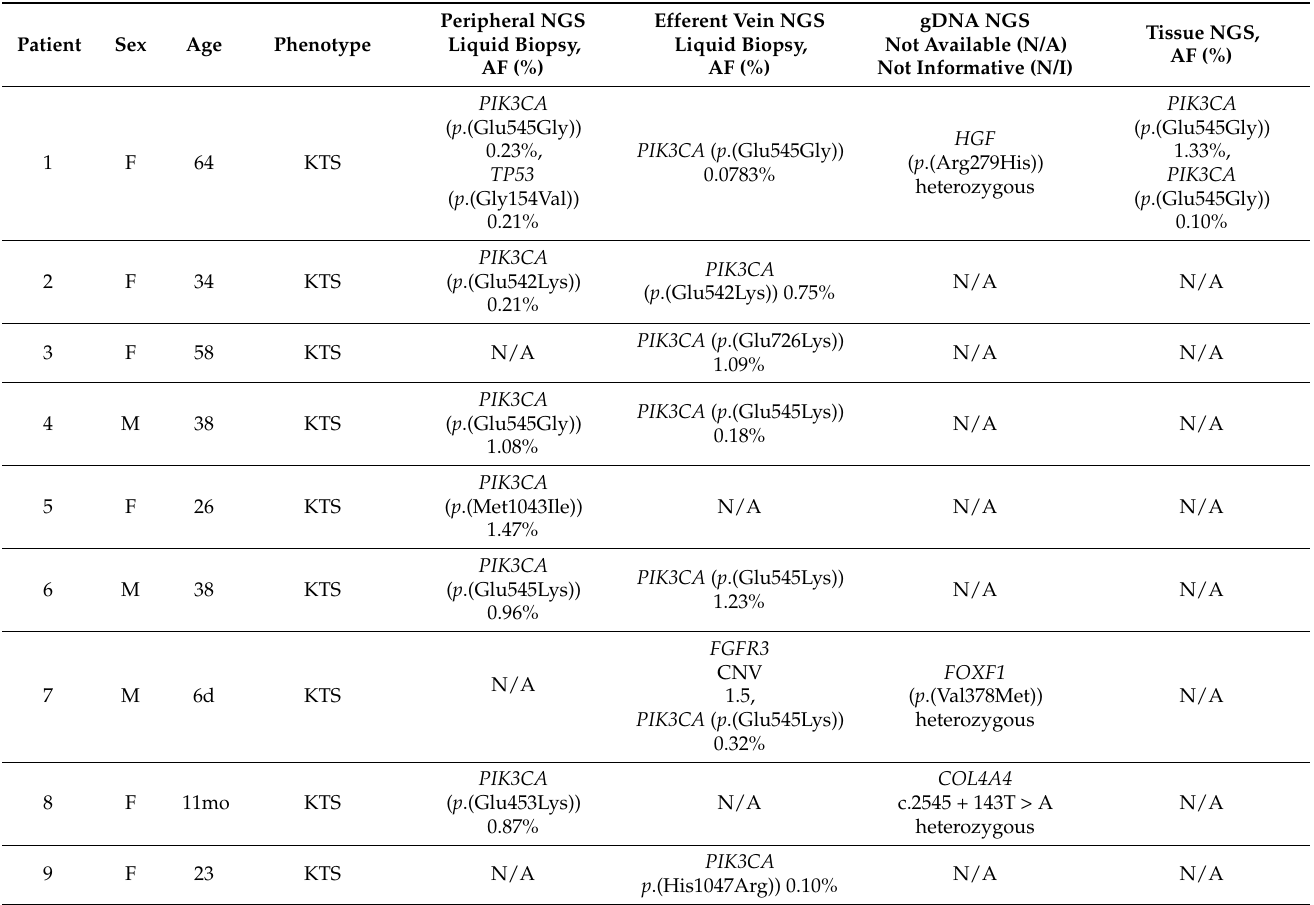
Table 1. Patients’ molecular characterization and clinical classification according to the ISSVA guidelines. The table reports the patient’s identification number, sex, age, mutations identified by peripheral NGS- liquid biopsy and their AFs, mutations identified by efferent vein NGS- liquid biopsy and their AFs, mutations found in gDNA and in tissues specimens by NGS analysis and their